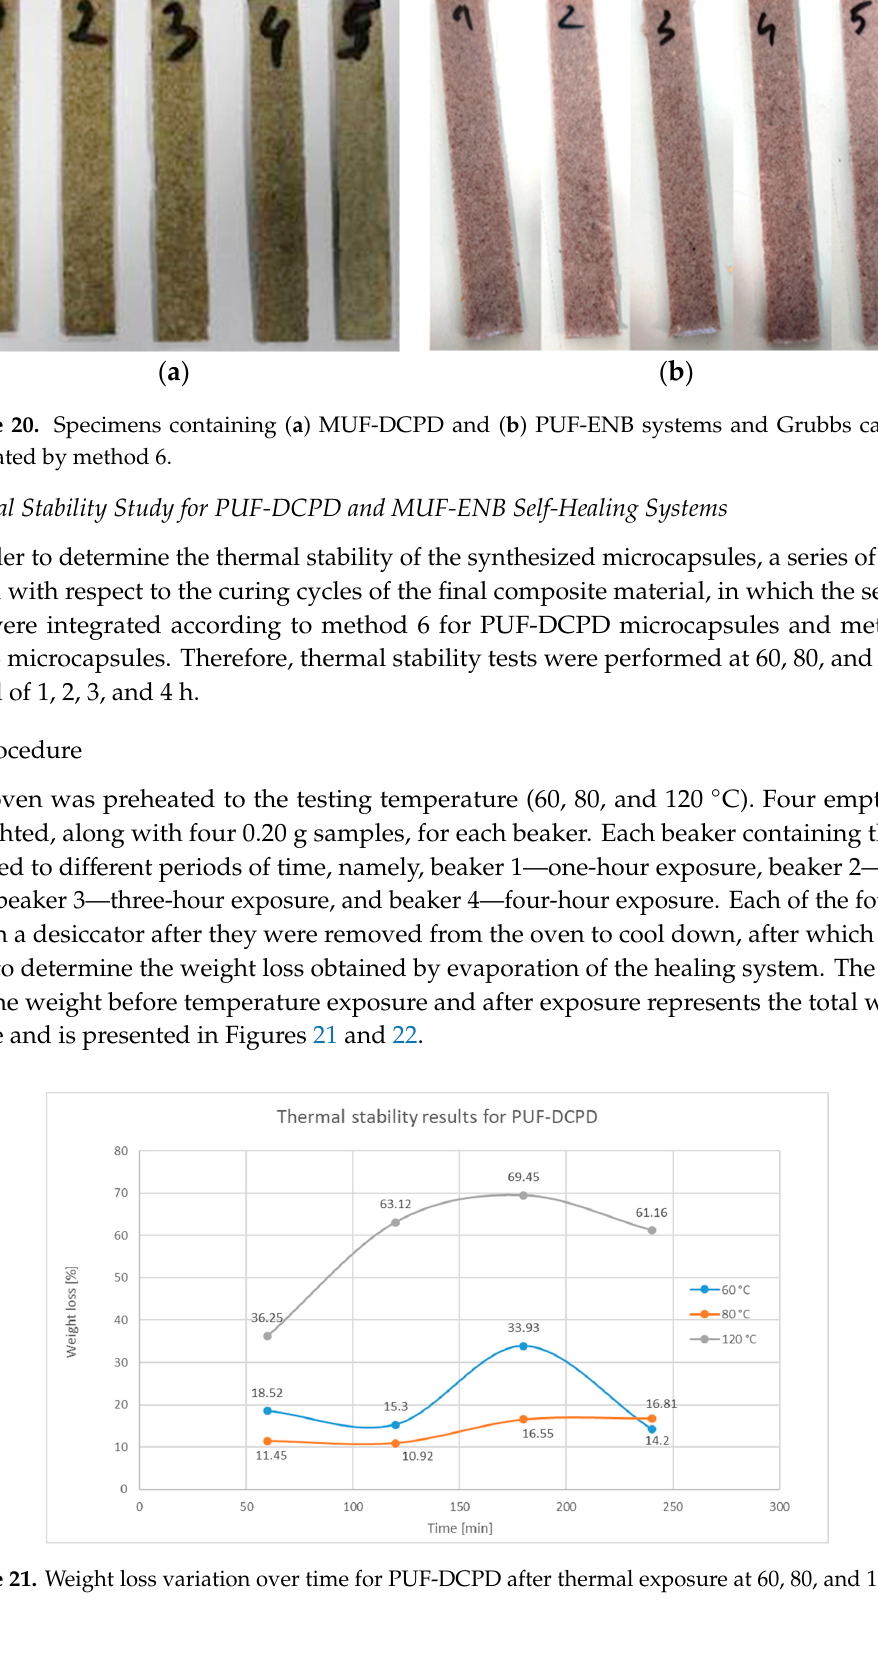
Figure 22. Weight loss variation over time for MUF-ENB after thermal exposure at 60, 80, and 120 °C. All samples were analysed under an optical microscope after being exposed to temperature, in order to determine the thermal stability, to ensure that the microcapsules retained their structure. It was observed that the majority of the PUF-DCPD and MUF-ENB microcapsules were not damaged, with the mass loss following the exposure to temperature taking place by evaporation of the repair agents dicyclopentadiene and ethylidene-norbonene, respectively, through the walls of the microcapsules. Although, in the case of exposure to the temperature of 120 °C, which is the temperature related to the polymerization cycle of the final composite material, the mass loss is substantial, this does not greatly influence the efficiency of the integrated healing systems, since the host matrix at 120 °C is already cured, having passed through a prepolymerization cycle at 60 and 80 °C, respectively.